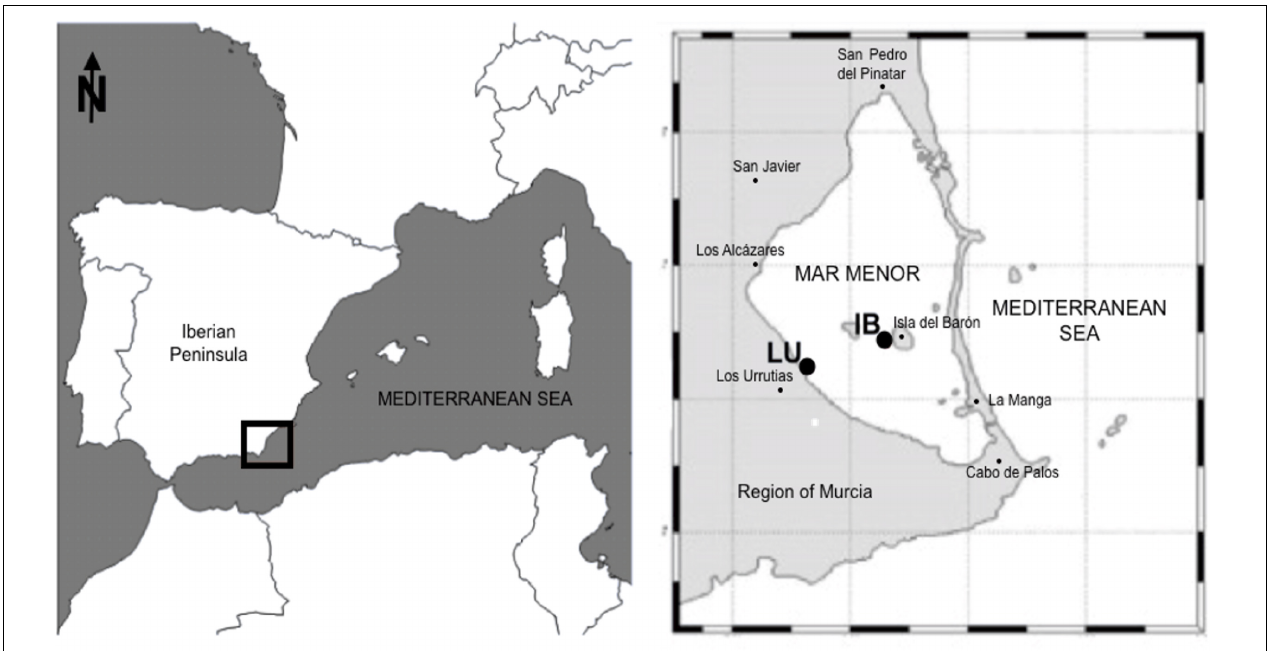
FIGURE 1 | Mar Menor sampling locations within the southwestern Mediterranean Sea (37 ◦ 44 (cid:48) N 0 ◦ 47 (cid:48) W). Sample points: Los Urrutias (LU) and Isla del Barón (IB).